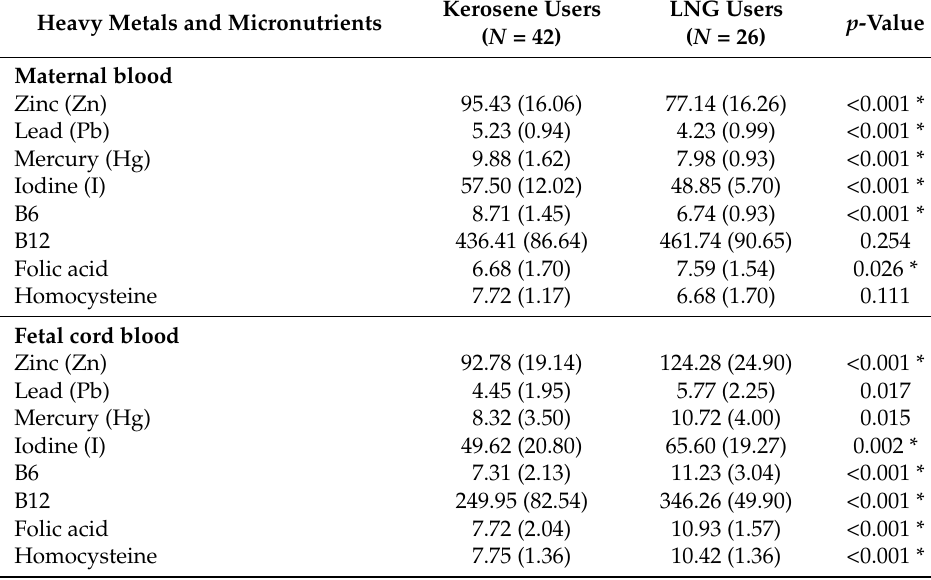
Table 3. Mean ( ± SD) micronutrient levels in maternal and cord blood cooking fuel group. Heavy Metals and Micronutrients